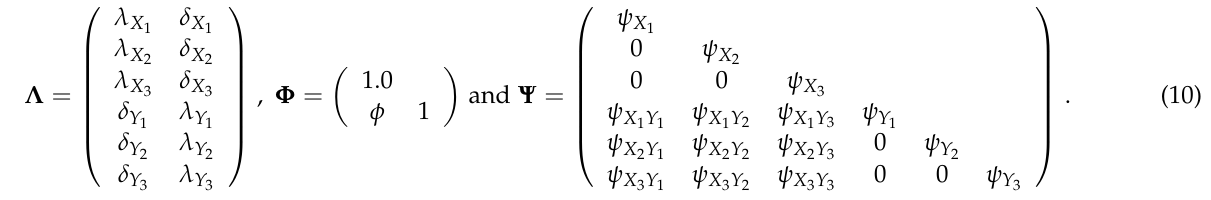
) and , δ X , δ X 2 3 1 X i Y j . However, we assume that X i Y j are collected in